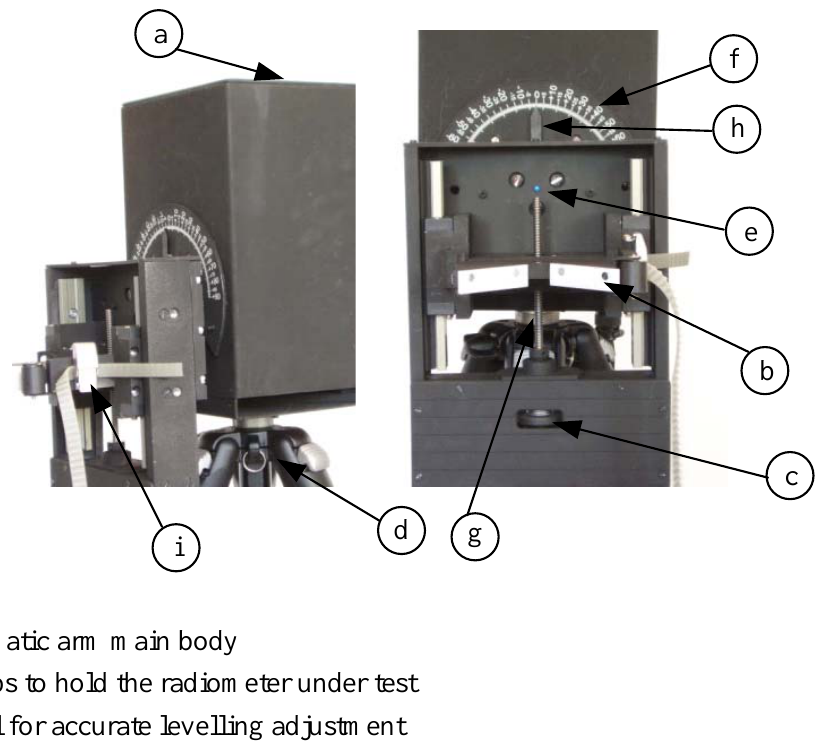
Figure 3. Front and profile view of the automatic